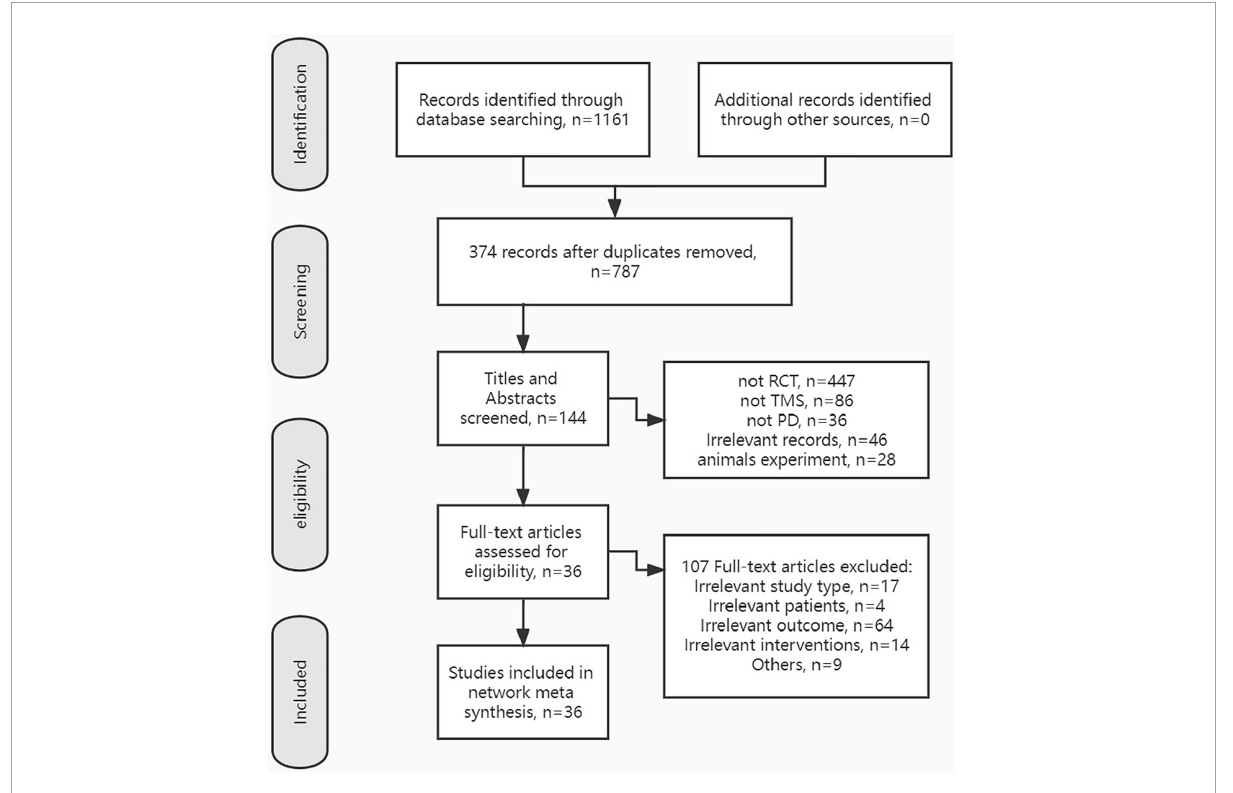
FIGURE1 Flow chart presents the literature searching and screening